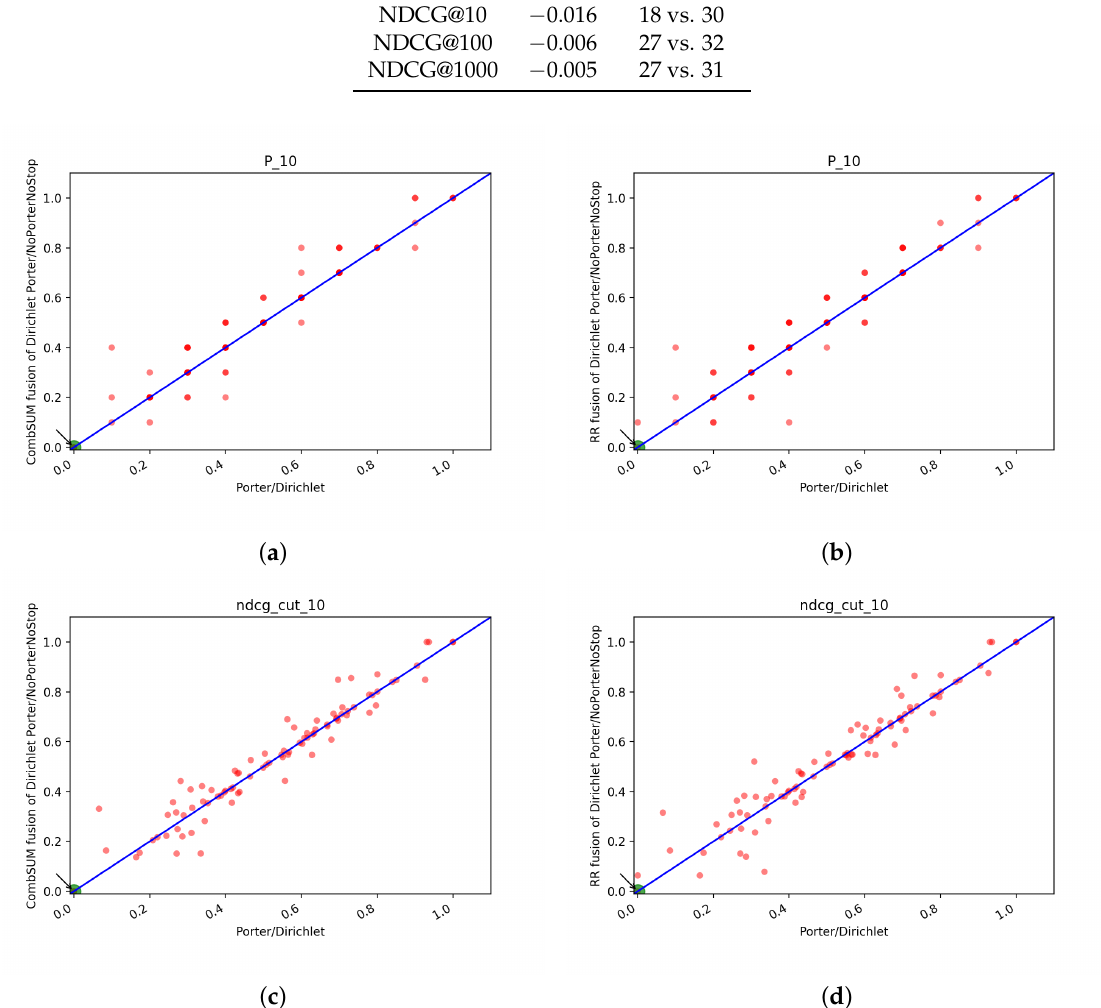
Figure 26. T2: scatter plots of the best run vs. the fusion of the two best runs: ( a ) P@10 for Porter/Dirichlet vs. CombSUM, ( b ) P@10 for Porter/Dirichlet vs. RR, ( c ) NDCG@10 for Porter/Dirichlet vs. CombSUM, ( d ) NDCG@10 for Porter/Dirichlet vs.